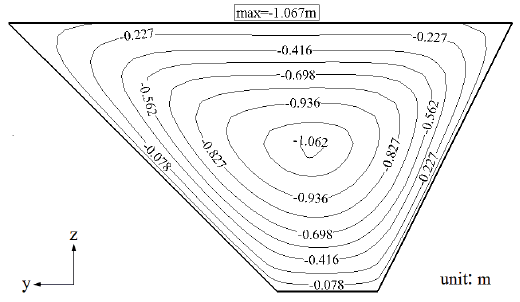
Figure 6. Settlement contour of ACC ( h = 200 m).